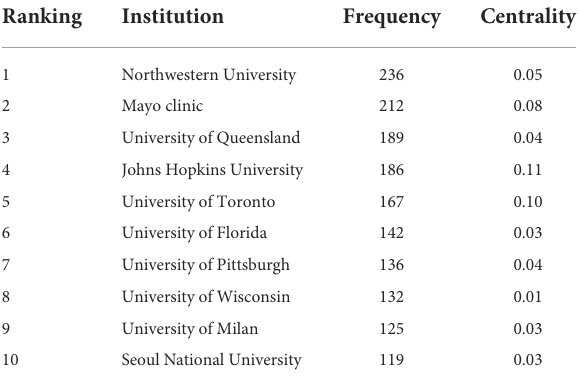
TABLE 2 The top ten productive institutions and centrality in the research field of dysphagia from 2012 to 2022.